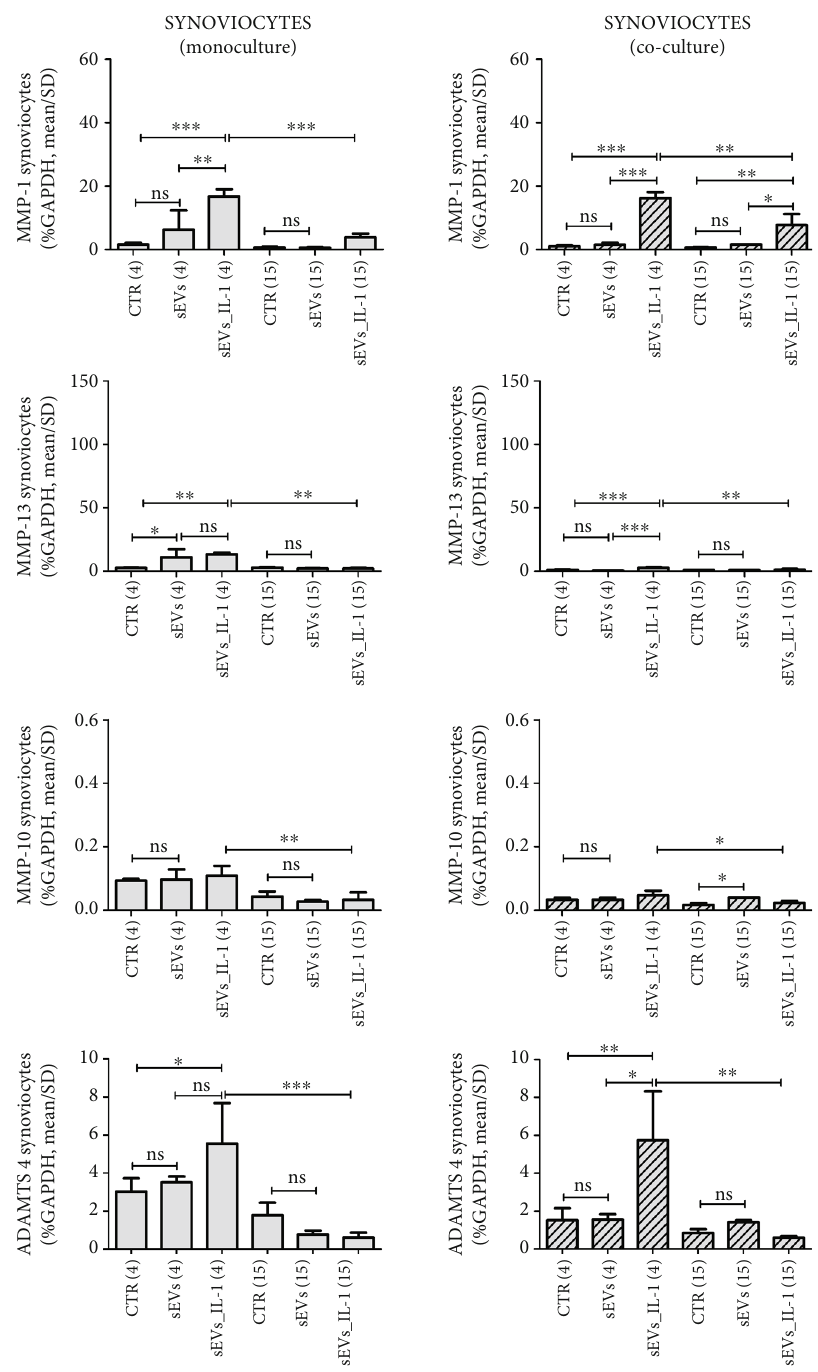
Figure 5: sEVs_IL-1 e ff ects on gene expression of catabolic genes in synoviocytes kept in control conditions. The fi gure reports the e ff ects on gene expression of major catabolic enzymes (MMP-1, MMP-13, MMP-10, and ADAMTS 4) in synoviocytes grown in both monoculture (grey pattern, left graphs) and co-cultured with chondrocytes (grey dashed pattern, right graphs) in CTR, sEVs, or sEVs_IL-1 conditions. Data were normalized to GAPDH. Each graph reports data collected from 3 independent sEVs samples and expressed as mean ± SD . The means of the groups were compared by ANOVA, followed by Tukey ’ s post hoc test, with ∗ p < 0 : 05 , ∗∗ p < 0 : 01 , and ∗∗∗ p < 0 : 001